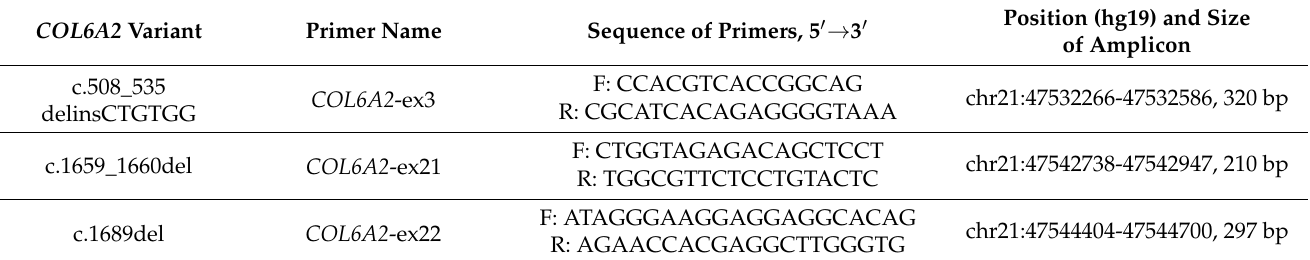
Table 2. Sequences of primers were used to validate revealed